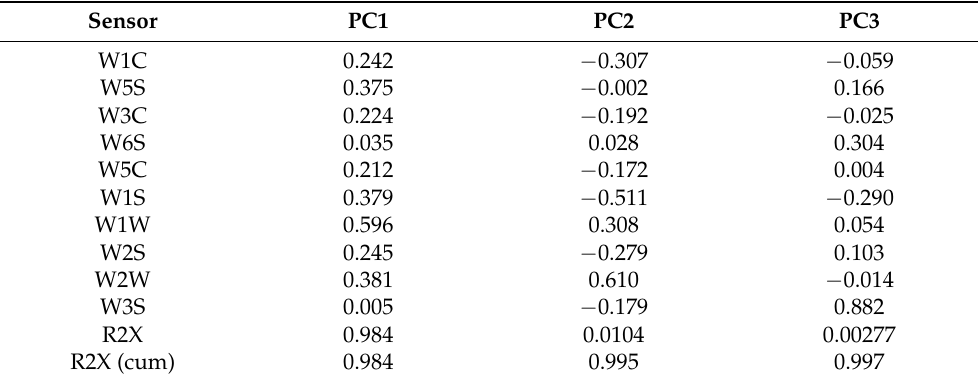
Table 1. Principal component factor loading for E–nose